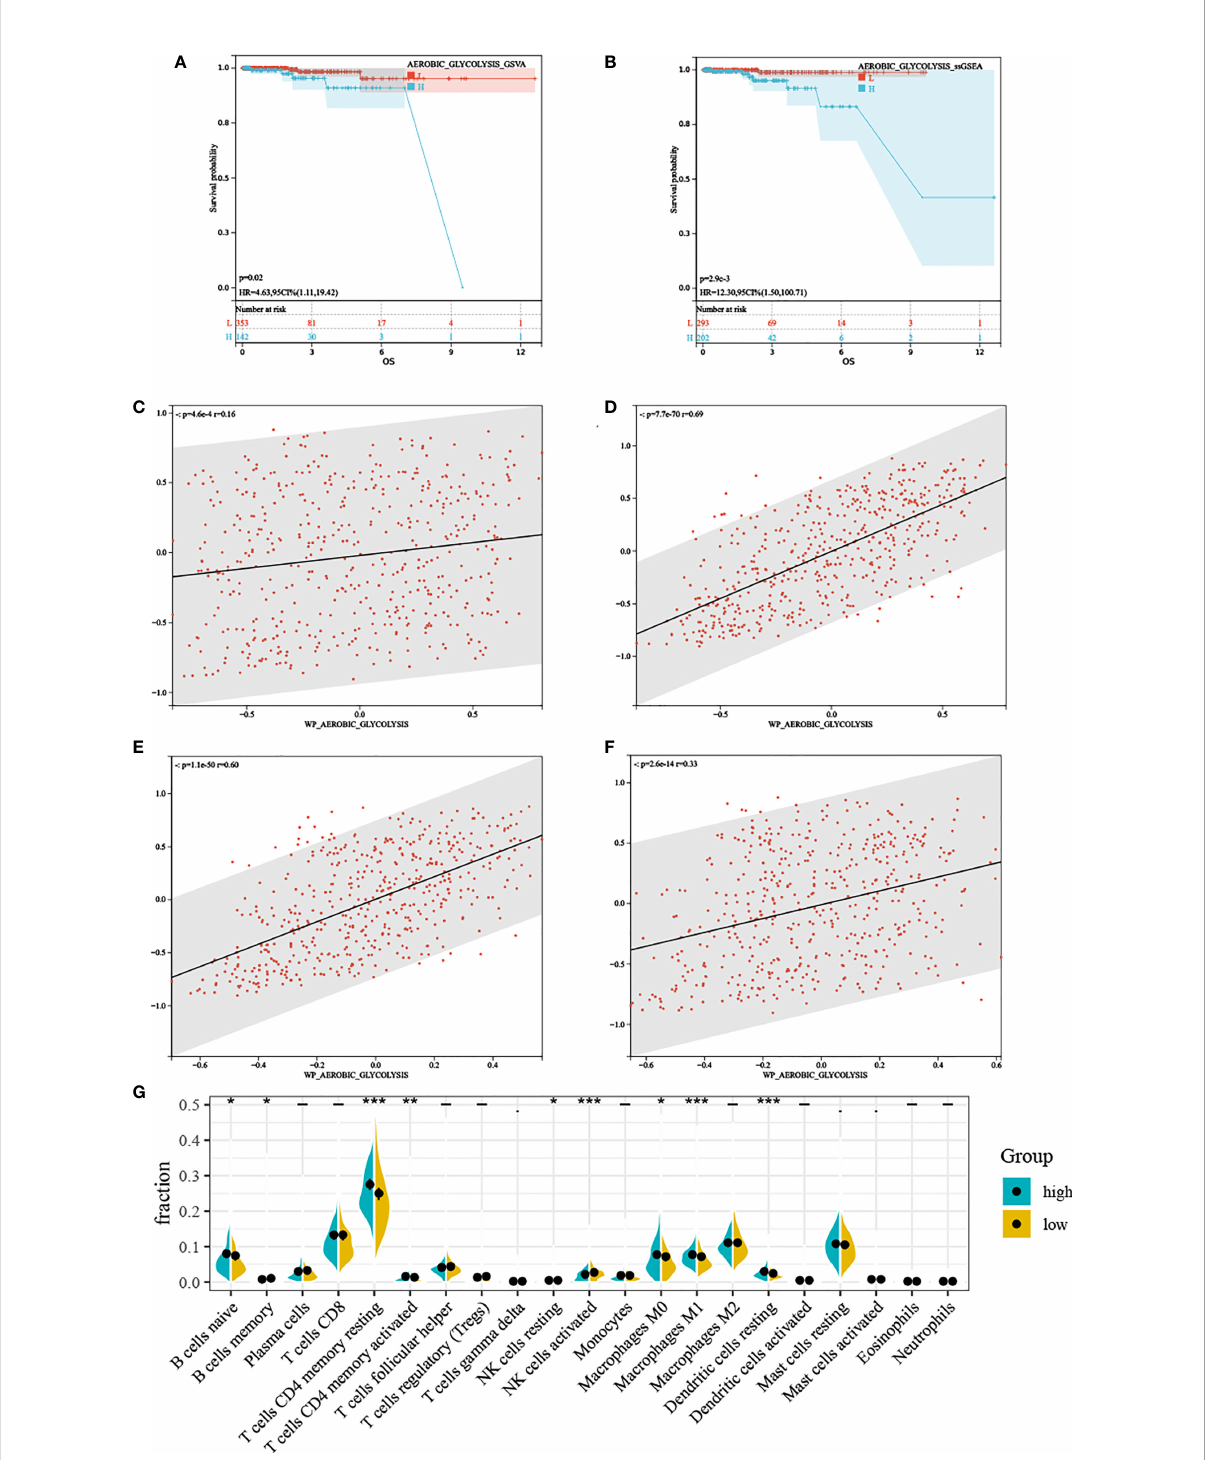
FIGURE 2 The characteristics between different aerobic glycolysis levels. (A, B) Kaplan – Meier plots indicating high aerobic glycolysis level patients have a shorter survival time. (C) The scatter plot shows a signi fi cant correlation between the glutamate metabolism and the aerobic glycolysis metabolism. (D) The scatter plot shows a signi fi cant correlation between the pentose phosphate metabolism and the aerobic glycolysis metabolism. (E) The scatter plot shows a signi fi cant correlation between the lactic acid metabolism and the aerobic glycolysis metabolism. (F) The scatter plot shows a signi fi cant correlation between the fatty acid metabolism and the aerobic glycolysis metabolism. (G) Relative proportion of in fi ltrating immune cells in low- and high- aerobic glycolysis level prostate cancer patient of TCGA-PRAD cohort. “ *, **, *** ” stands for statistically signi fi